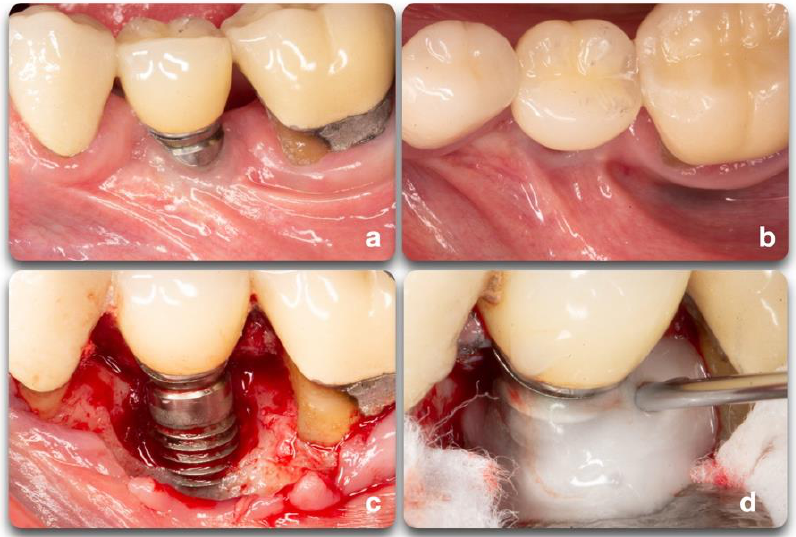
Figure 7. Clinical scenario representing a peri-implant defect affecting implant #20. A lack of keratinized mucosa ( a ) and frenum pull ( b ) could have played an important role in the defect shown ( c ). After mechanical debridement with curettes and titanium rotary brushes, the surface was treated with 24% EDTA gel to provide the chemical surface decontamination ( d ).